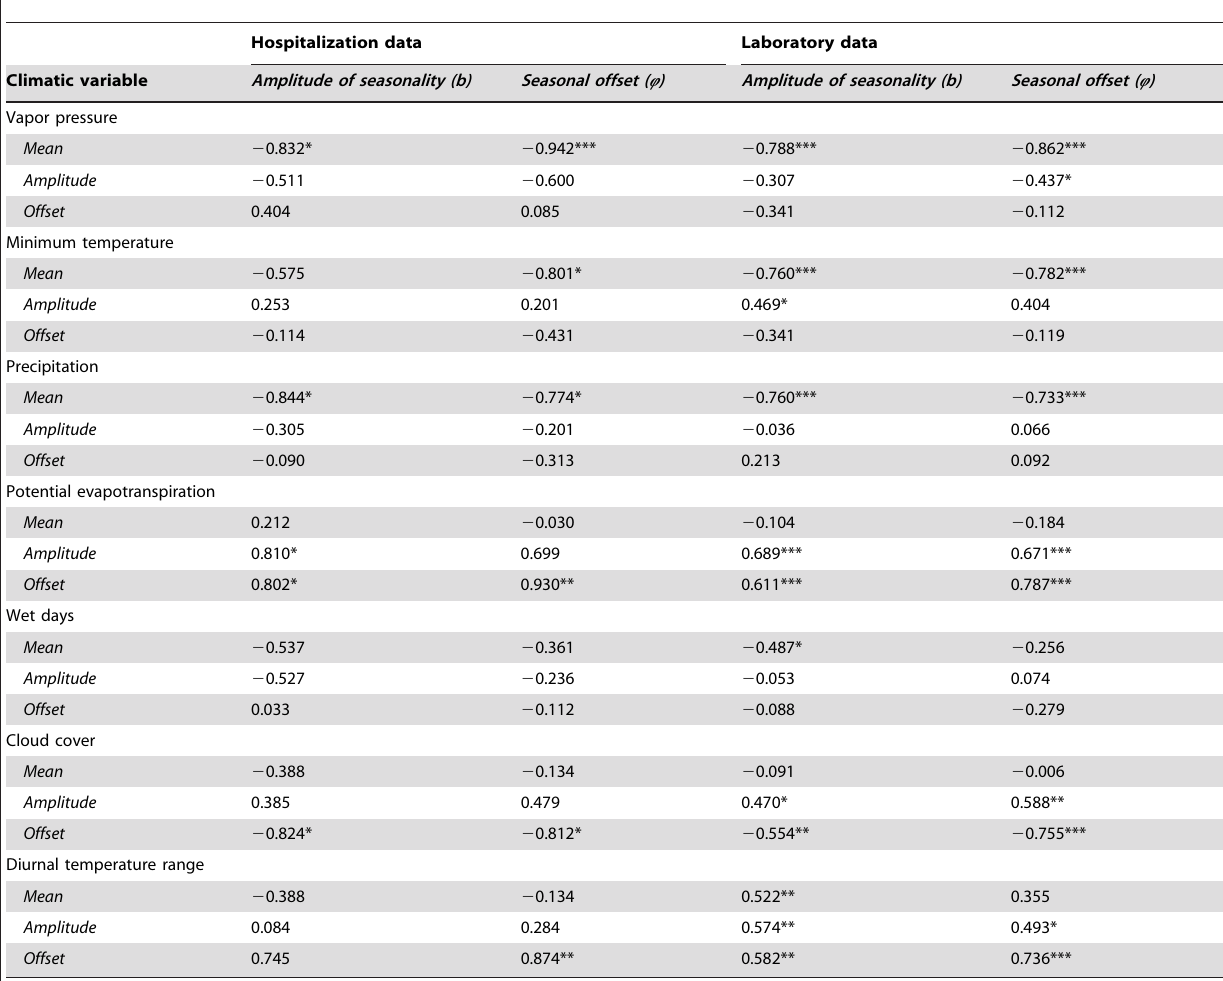
Table 3. Correlation coefficients between climatic variables and estimated seasonality parameters in RSV transmission